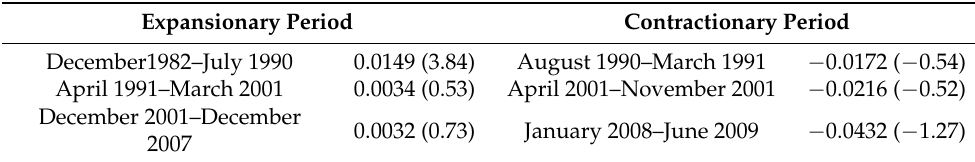
Table 3. Business cycle and momentum.